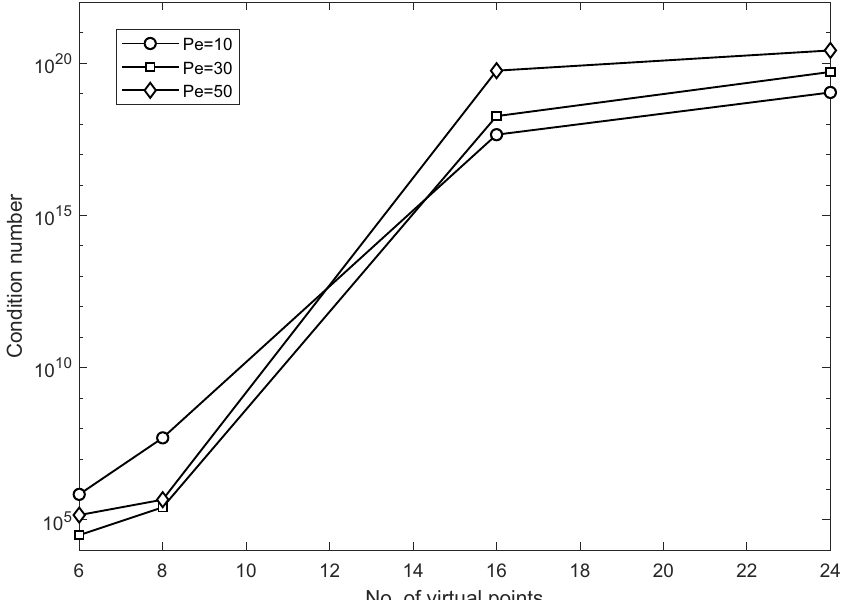
Figure 17. Example No. 1—connection of the local condition number and number of virtual points.